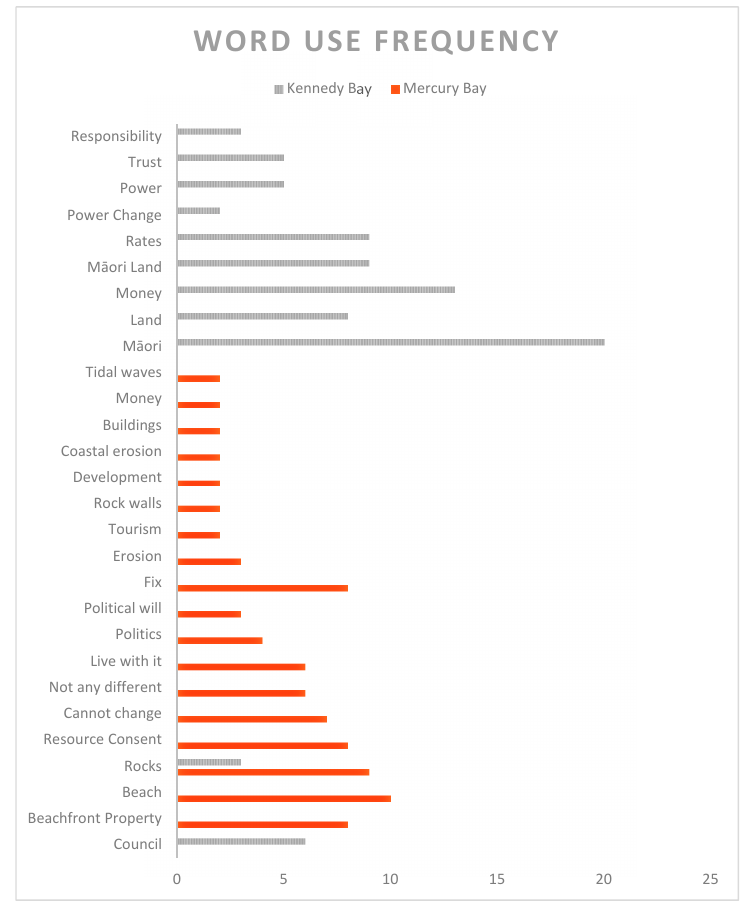
Figure 4. Word use frequency in Kennedy Bay and Mercury Bay interviews.